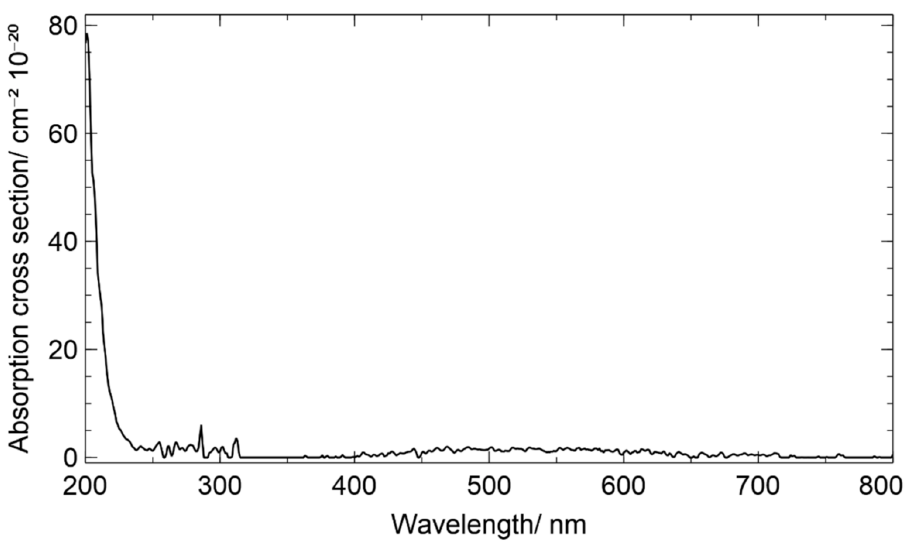
Figure 3. Gas phase UV/VIS Spectrum of 1,2-ISOPOOH, measured in a diluted gas stream at a mixing ratio of approximately 6.61 × 10 13 molecules · cm − 3